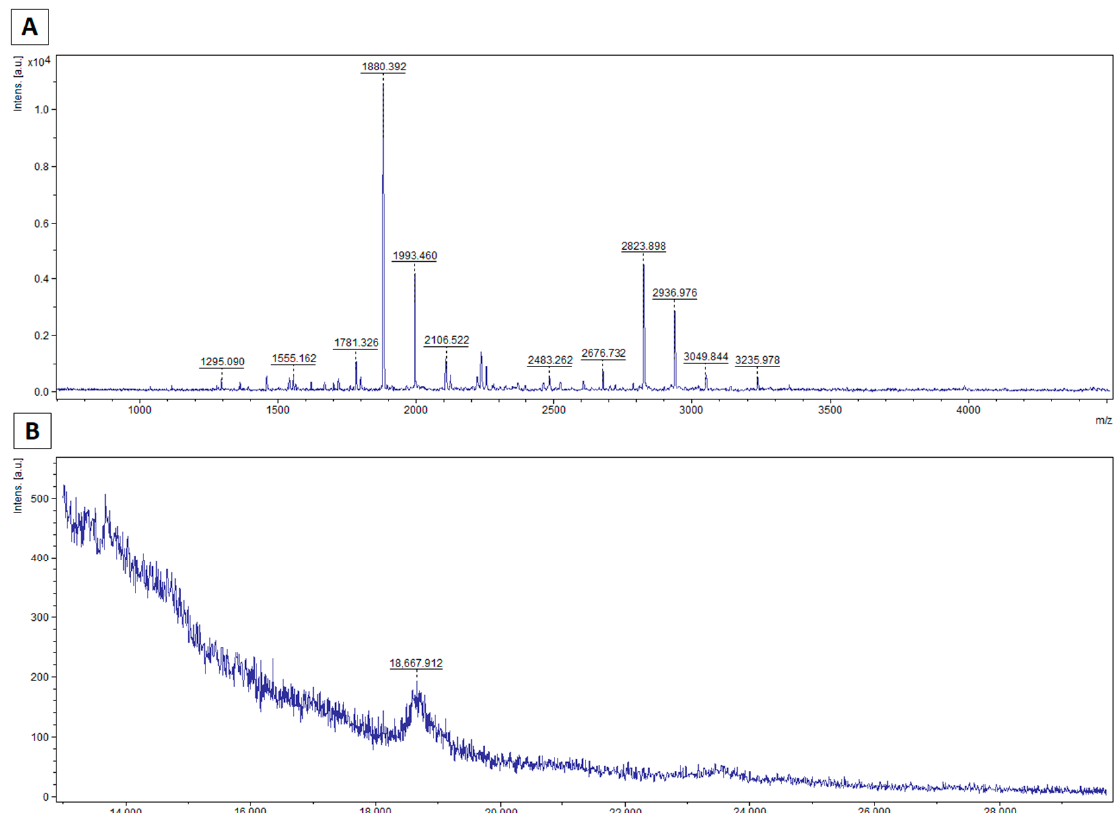
Figure 4. Spectra acquired for casein treated with curly kale extract for 8 h ( A ) for low molecular masses (0.7–5 kDa) using the HCCA matrix; ( B ) for molecular masses in the casein range (13–30 kDa) using the HCCA+DHB matrix.